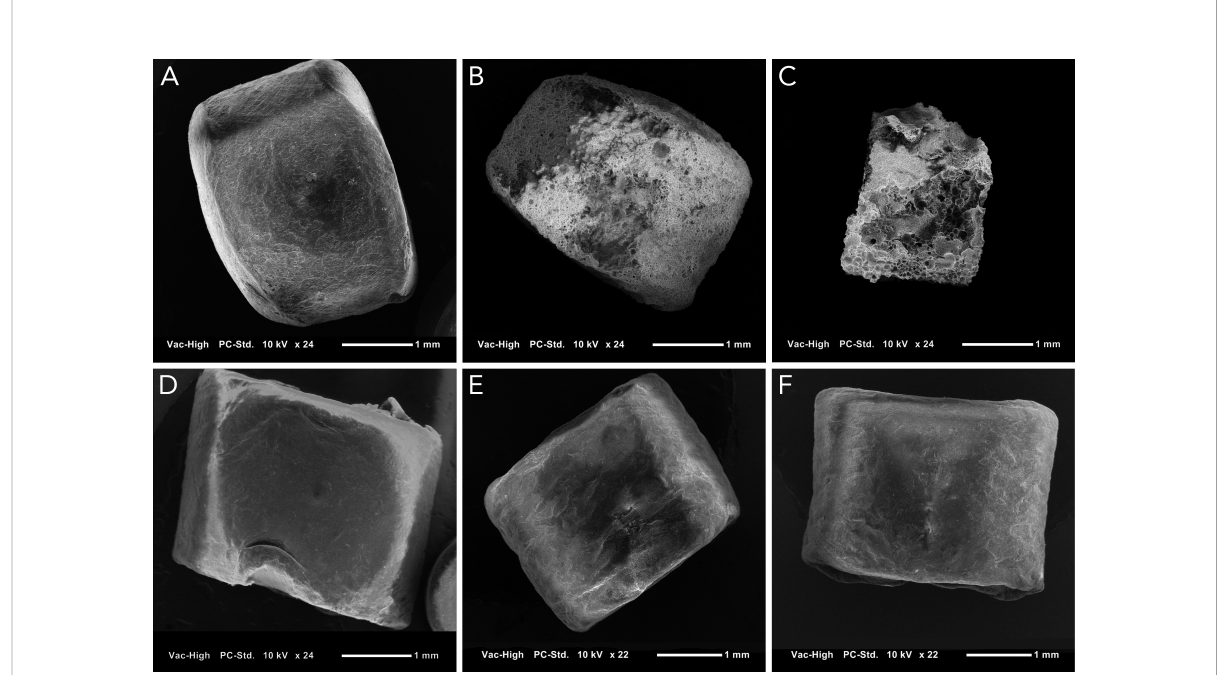
FIGURE 2 Scanning electron images of PHA and PET pellets without their associated bio fi lm to display changes to the polymer surface at approximately 25X magni fi cation. (A – C) show PHA pellets after 0, 202, and 424 days of exposure, respectively. (D – F) show PET pellets after 0, 202, and 424 days of exposure, respectively. Extensive pitting is present on PHA pellets, but the surface of PET appears